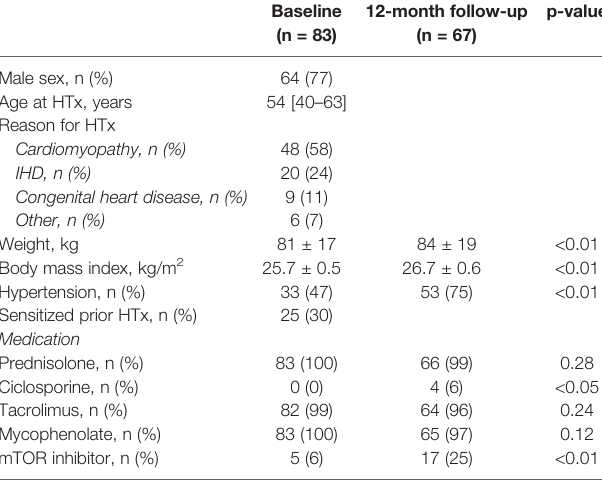
TABLE 1 | Baseline characteristics according to rejection